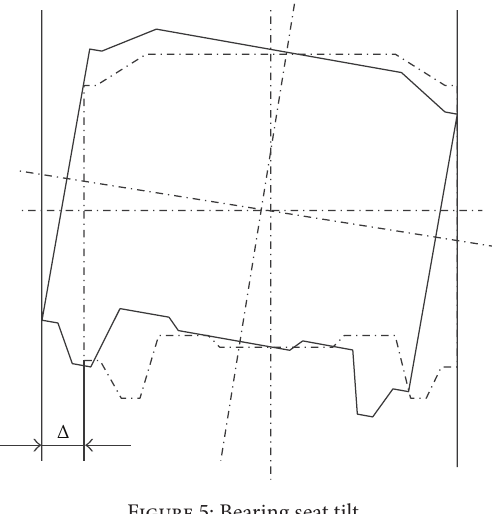
Figure 5: Bearing seat tilt.